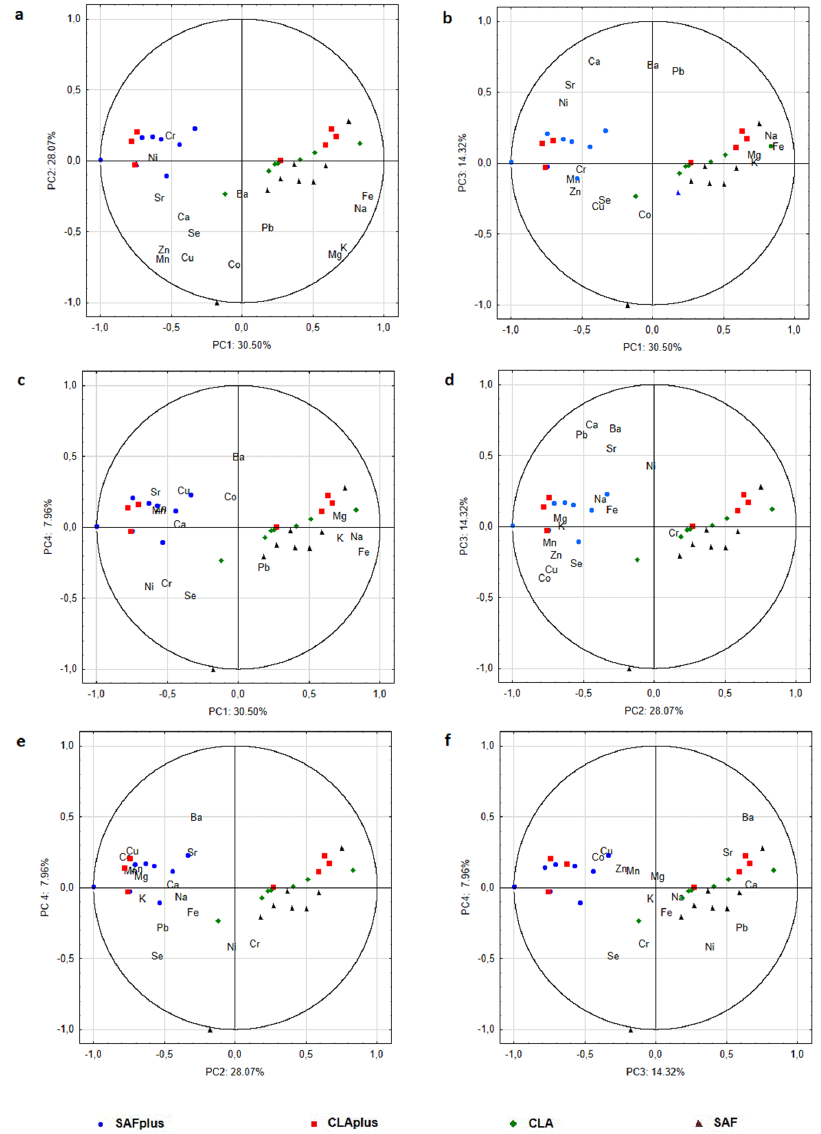
Figure 3. Biplots of minerals content in the myocardium of rats of experimental groups: ( a ) PC1 × PC2, ( b ) PC1 × PC3, ( c ) PC1 × PC4, ( d ) PC2 × PC3, ( e ) PC2 × PC4 and ( f ) PC3 × PC4. SAF group—animals receiving safflower oil; SAFplus group—animals receiving safflower oil